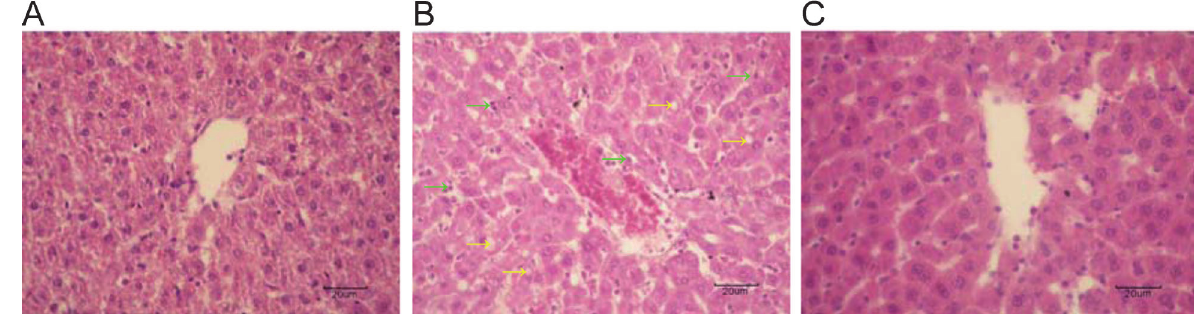
Figure 1. Effect of exogenous normal lymph (ENL) on hepatic morphology in rats (HE staining, 400 6 , magnification bar: 20 m m). Hepatic tissue was collected 6 h after lipopolysaccharide (LPS) injection in LPS and LPS++ENL groups, or the corresponding time in the sham group (n=3). A , Sham group, regular arrayed hepatic cords, as well as the uniform-sized hepatic cells with round nuclei and clear karyolemmas were observed; B , LPS group, the central vein and its surrounding hepatic sinusoid were dilated and congested, the hepatic cells showed turbid swelling, steatosis, and cytoplasmic vacuolation (yellow arrows), neutrophil and accidental eosinophil neutrophil infiltrations (green arrows) were found; C , LPS++ENL group, the hepatic cords were relatively unimpaired, and the architecture of hepatic lobules was normal, the changes of hepatic structure were slighter than those of the LPS